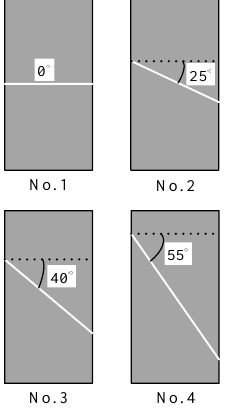
Figure 2. Cutting scheme of the cylindrical plug core models with oblique fractures; the white, solid line demonstrates the fracture pattern.